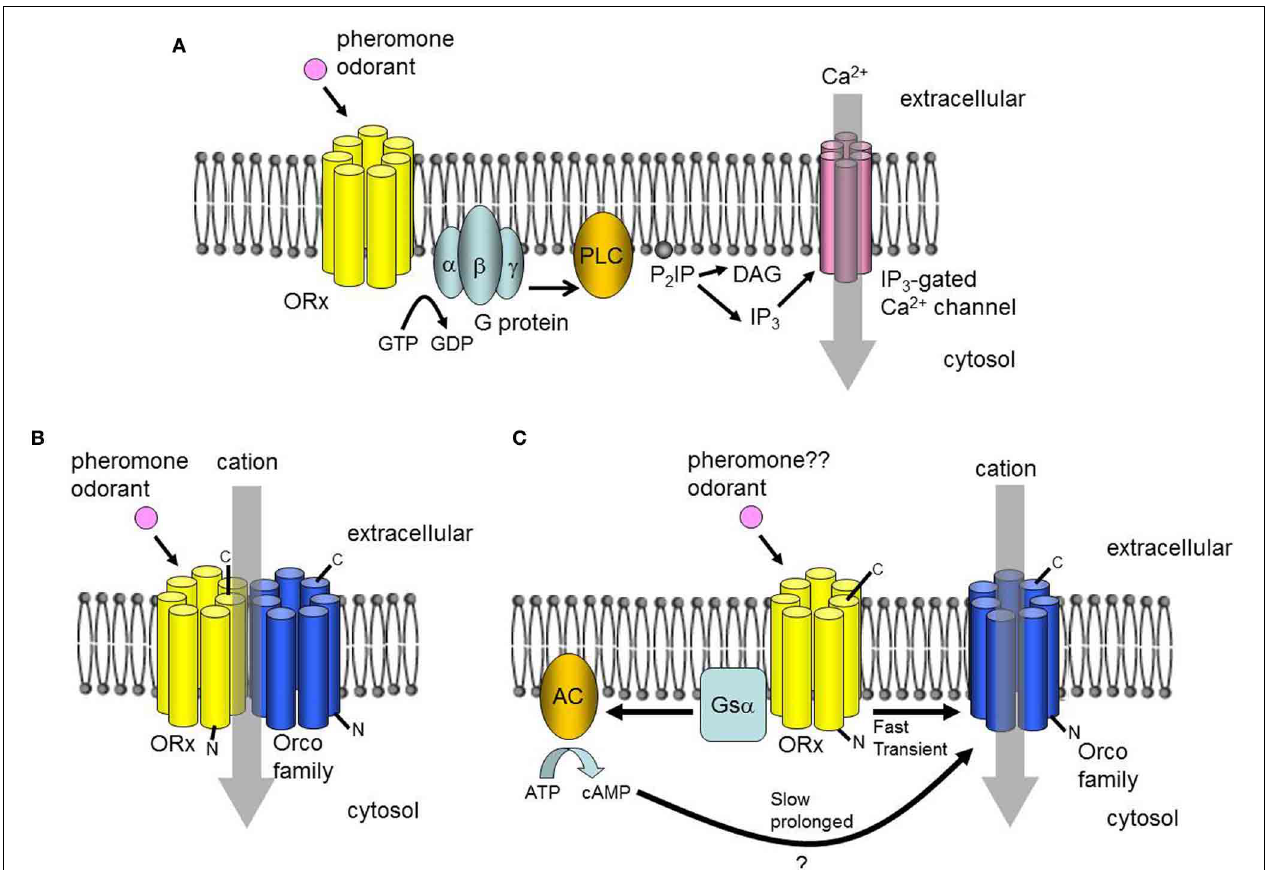
FIGURE 2 | Proposed signal transduction mechanisms. (A) A classical model of insect olfactory transduction that involves a G-protein-mediated PLC-IP3 pathway. (B) Alternative model in which the odorant receptor (OR) forms a heteromeric odorant-gated non-selective cation channel with an Orco family protein. (C) Alternative model postulating two pathways,